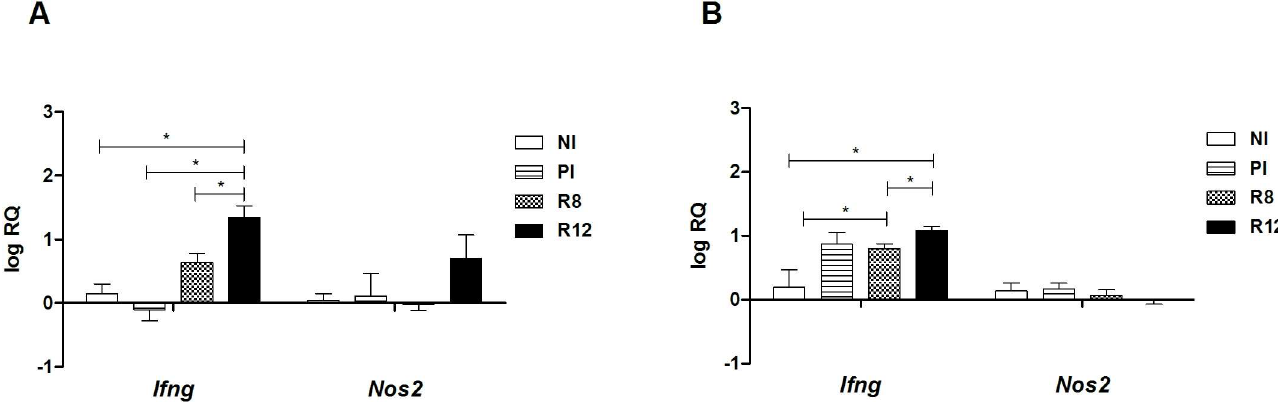
Fig 3. Effect of Fasciola hepatica reinfection on the Ifng and Nos2 expression from the spleen and thymus. A) Spleen.B) Thymus. Group NI: non-infected controls; Group PI: rats received a singleinfection dose; Group R8: infected and reinfected rats at 8 weeks after primary infection; Group R12: infected and reinfected rats at 12 weeks after primary infection. P < 0.05 was considered statisticallysignificant.Bars represent mean ± SE values. * Statistically significantdifferences (P < 0.05,Mann-Whitney non-parametric test).